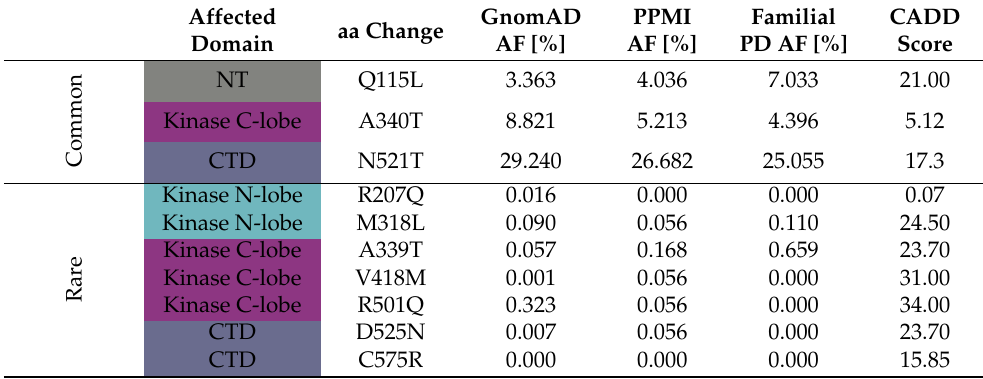
Table 2. Common and rare variants in PINK1 . Common (>1%) and rare variants (<1%) in PINK1 are listed together with their color-coded domain, the caused amino acid change and the allele frequencies (AF) in GnomAD, the PPMI cohort and a familial PD cohort. Shown is also the CADD score, a computational prediction for the deleteriousness of the mutation. CADD scores were generated with GRCh38